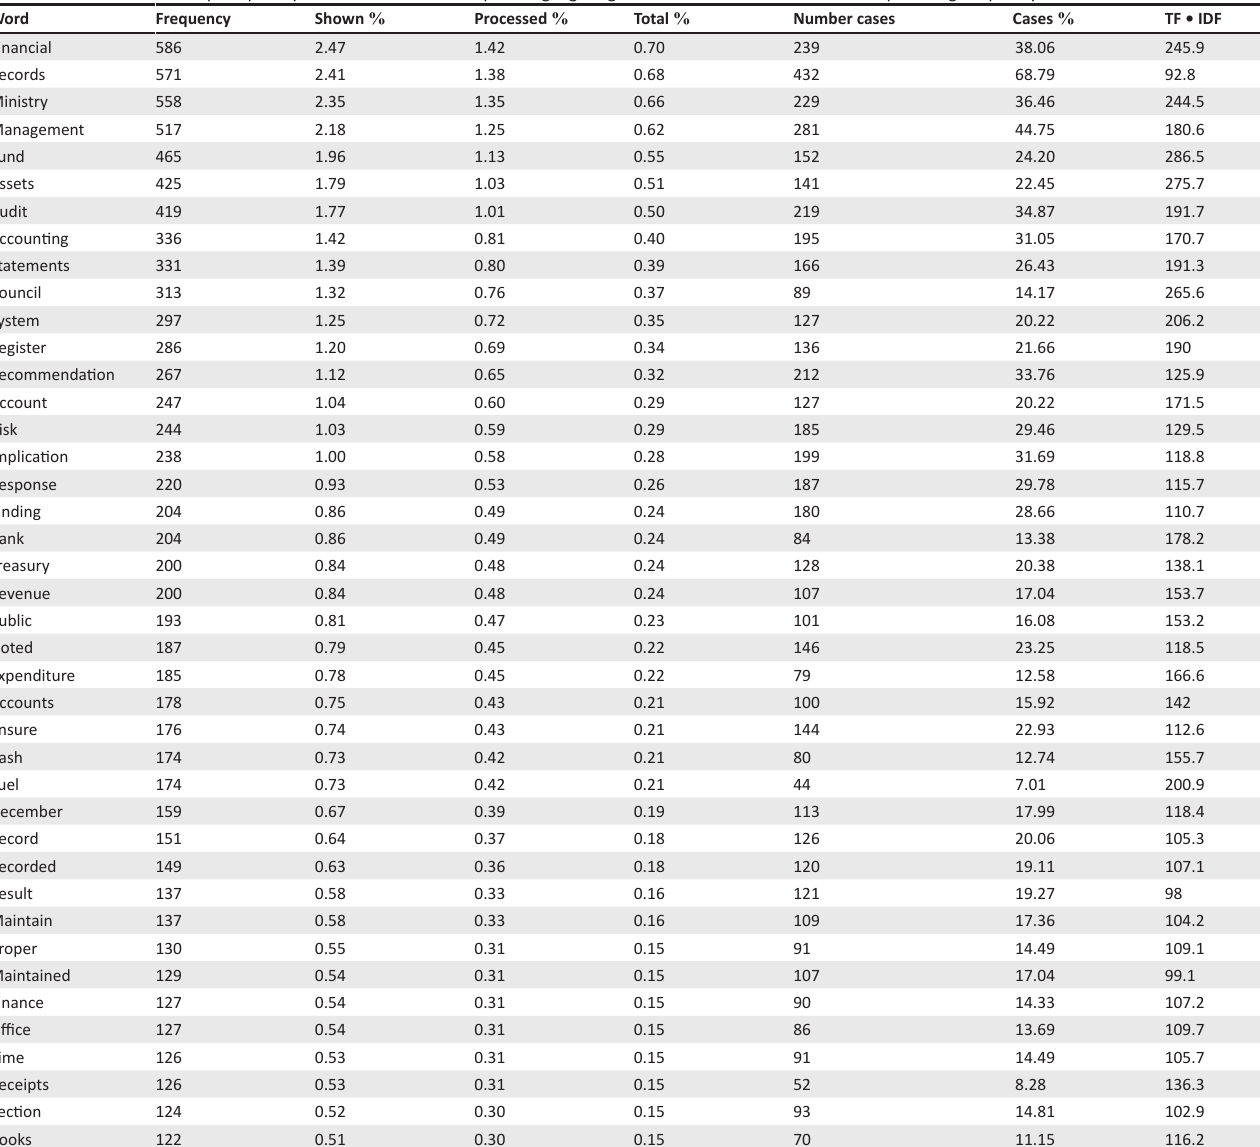
TABLE 3: An extract of the top frequently used words in the six reports highlighting the use of record -related terms emphasising frequency of reference.